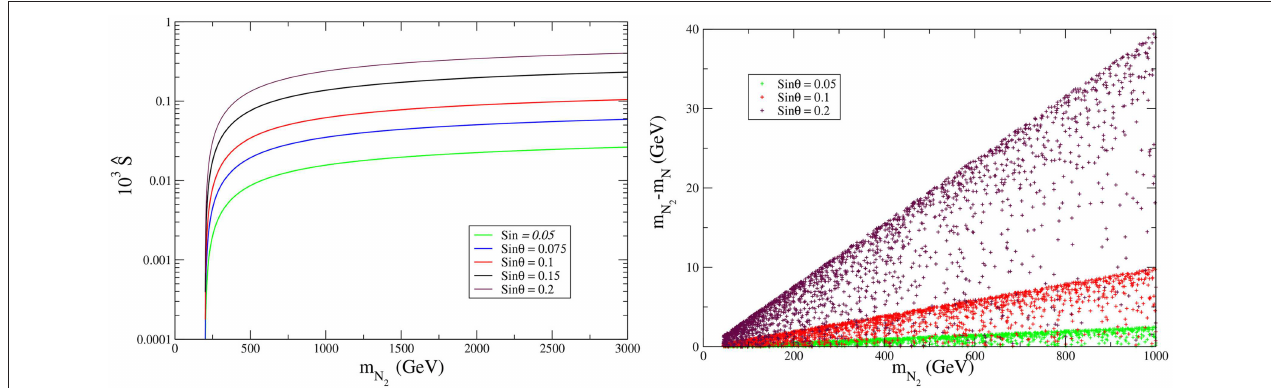
for m N 200 GeV and sin θ 2 1 =